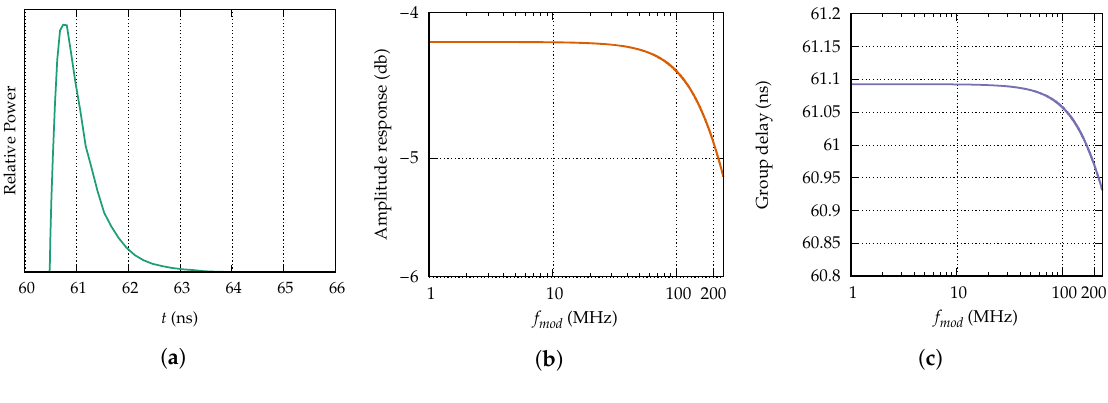
Figure 12. Simulated impulse response ( a ), amplitude response ( b ) and group delay ( c